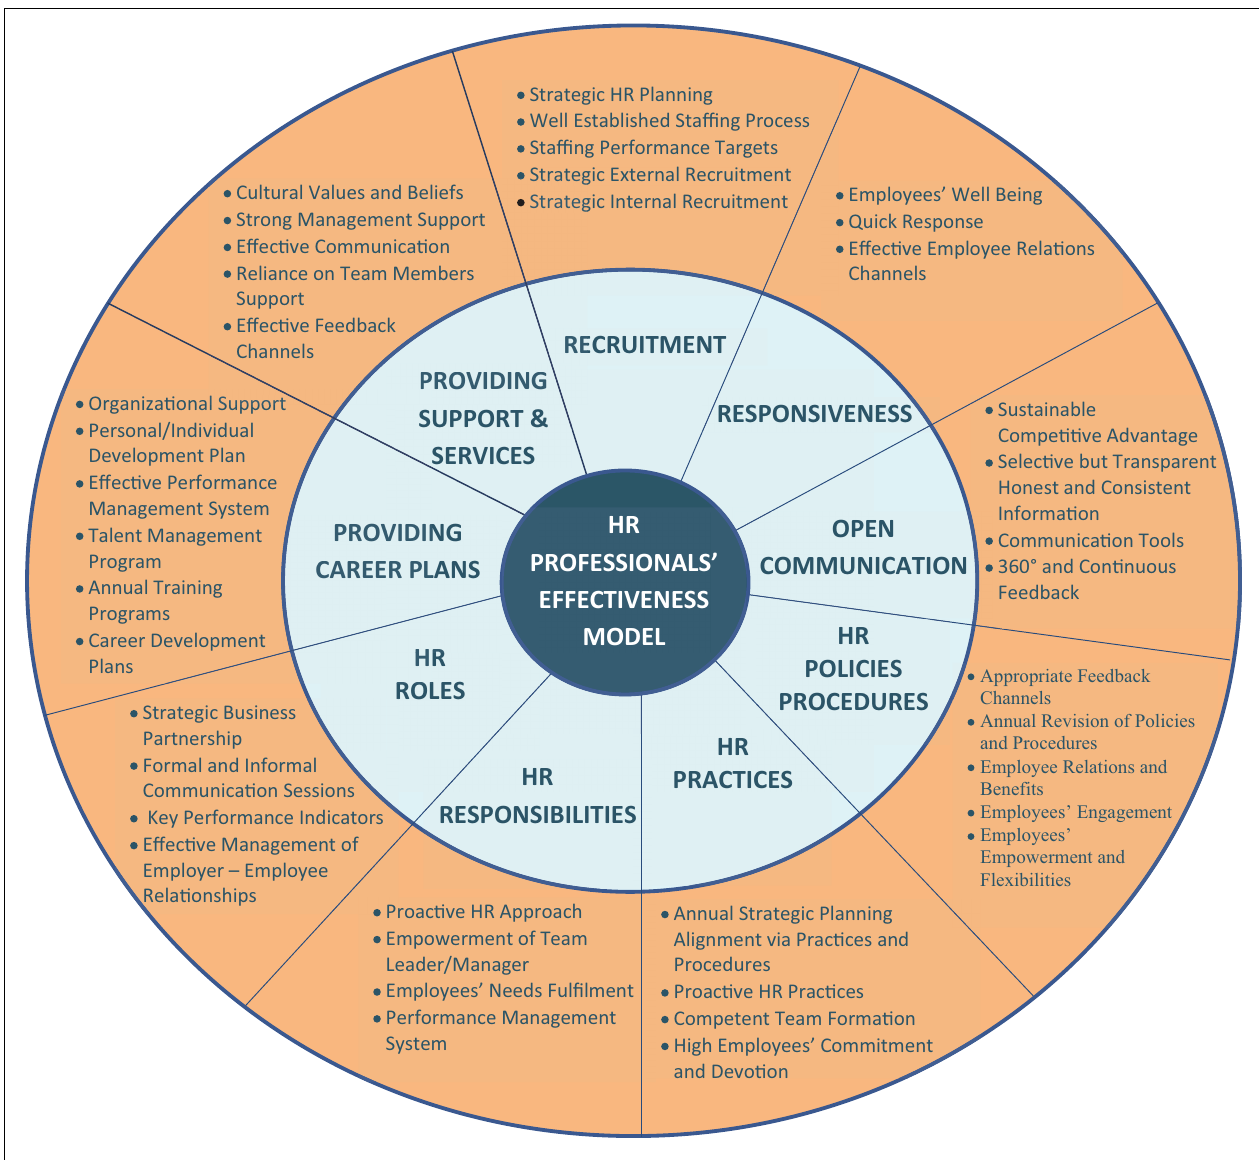
FIGURE 1 | Summary of the findings. (HR professionals’ effectiveness